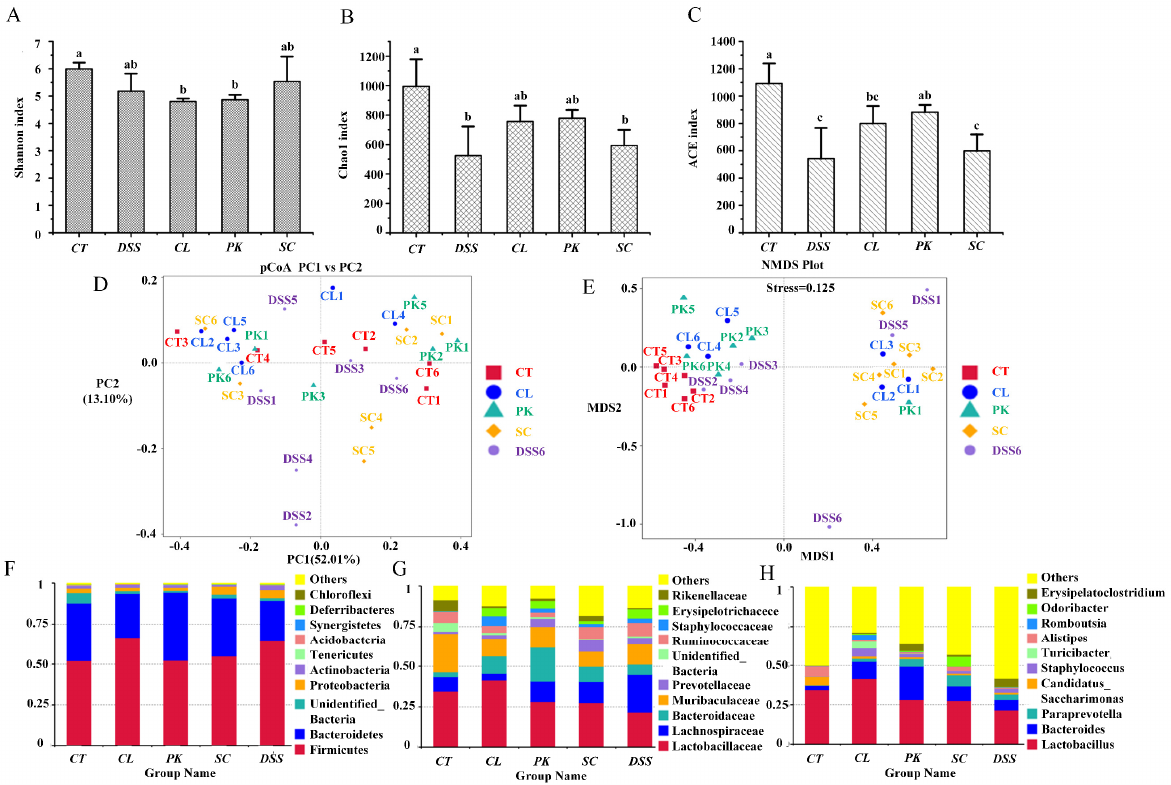
Figure 4. Intestinal microflora diversity and gut microbiota composition of Balb/c mice in different groups. ( A − E ) Shannon index, Chao 1 index, ACE index, PCoA, NMDS of each group; bar picture of the gut microbiota at the ( F ) Phylum level, ( G ) Family level, ( H ) Genus level. Different lowercase letters marked on the column represent significant difference ( p < 0.05).